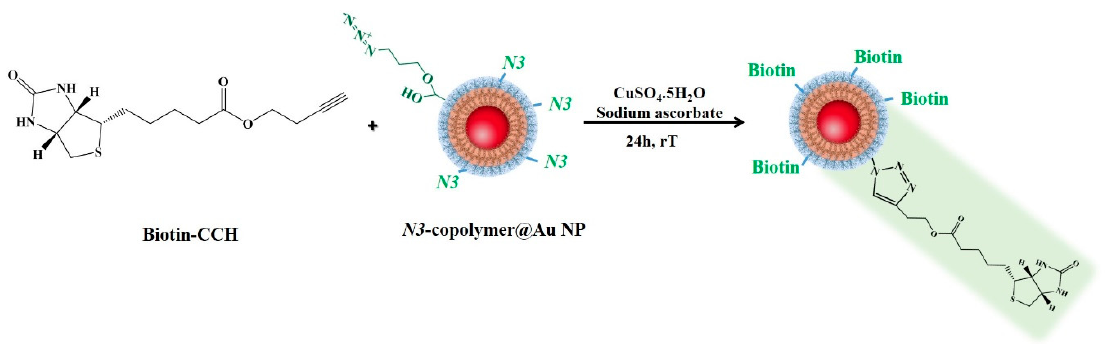
Schematic representation of biotinylation of N3 –copolymer@Au NPs via the click chemistry reaction.